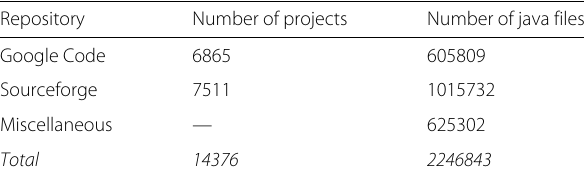
Table 3 Distribution of projects in part “aa” of the Sourcerer